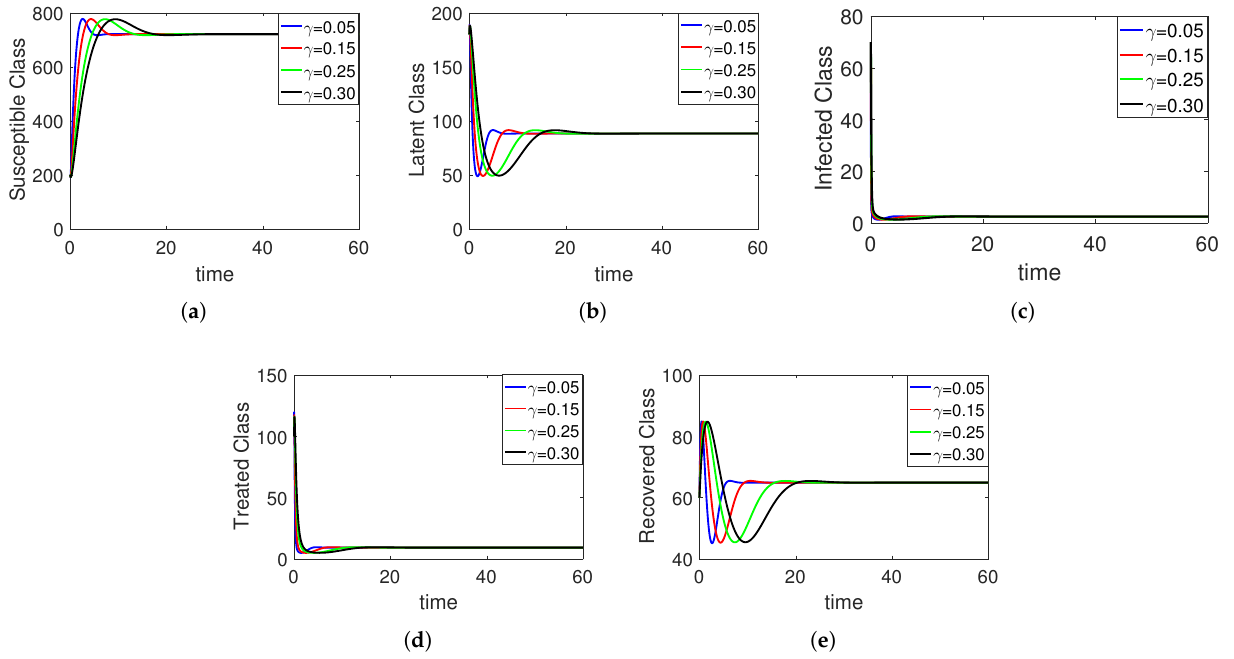
Figure 3. A graphic view of all five agents ( a – e ) of human society on different arbitrary orders γ = 0.05, 0.15, 0.25, 0.30 for initial data and time duration.